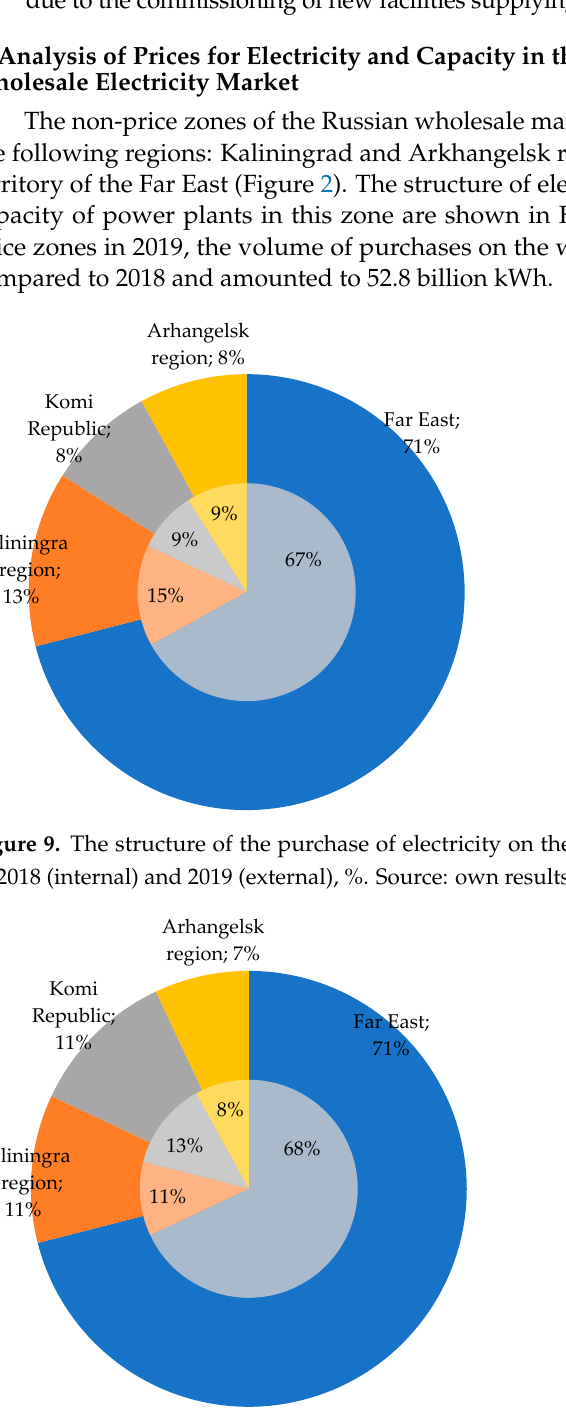
Figure 10. The structure of the installed capacity of the wholesale market power plants in non-price zones in 2018 (internal) and 2019 (external), %. Source: own results.